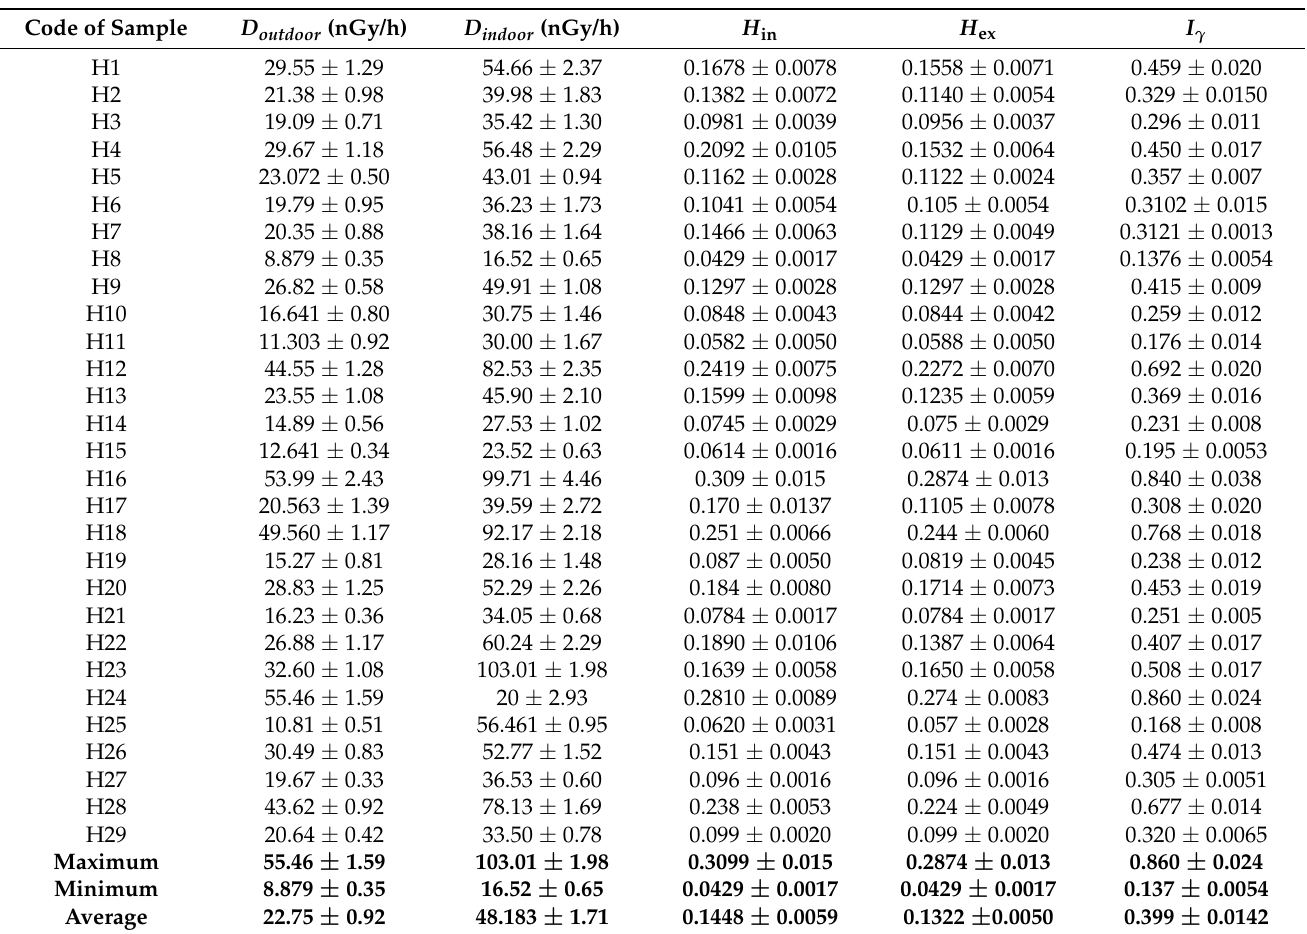
Table 6. Outdoor and indoor absorbed dose rate, internal hazard index (H in ), external hazard index (H ex ), and radioactivity level index (I γ ) for different medicinal plant samples.